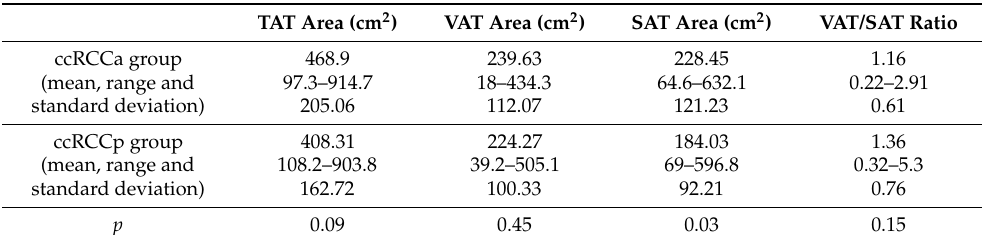
Table 3. Mean, range and standard deviation of the ccRCCa group and ccRCCp group and Student’s t -test results.